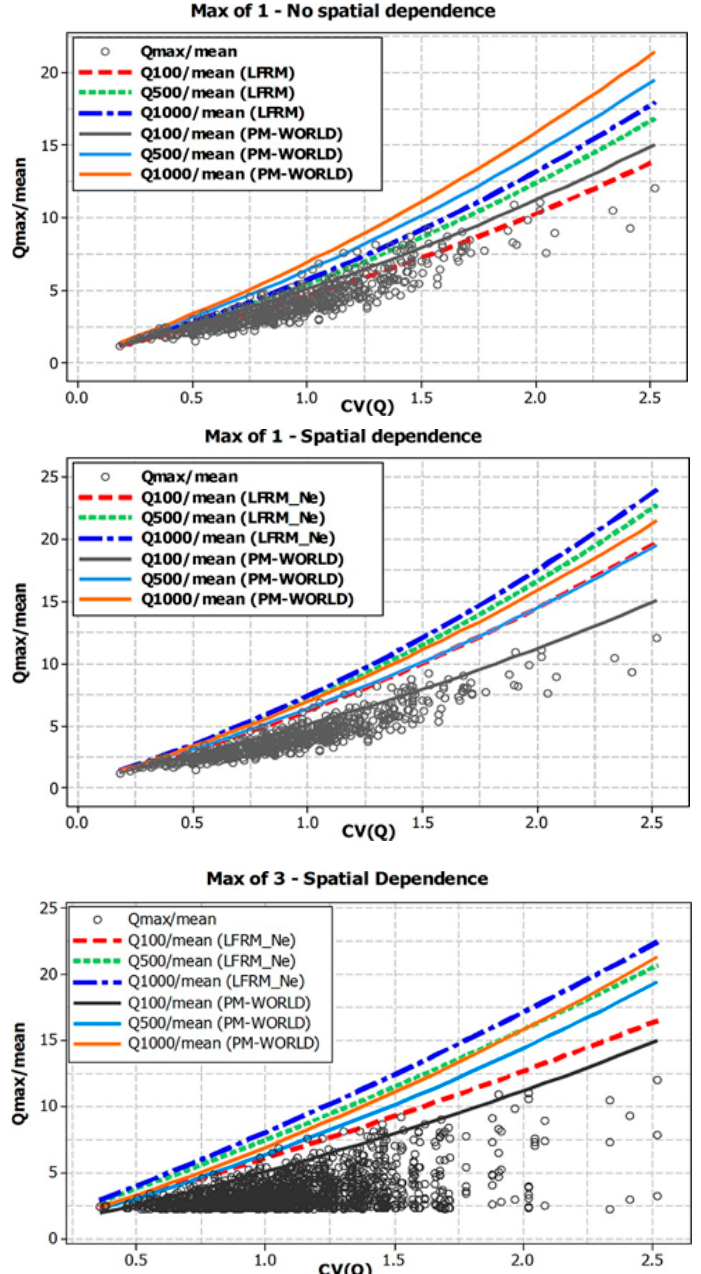
Figure 7. Various Q max / mean quantiles derived from the LFRM_N e model and PM (World) model. (Top panel) Maxima 1—no spatial dependence; (middle panel) Maxima 1—spatial dependence accounted for; (bottom panel) Maxima 3—spatial dependence accounted for.